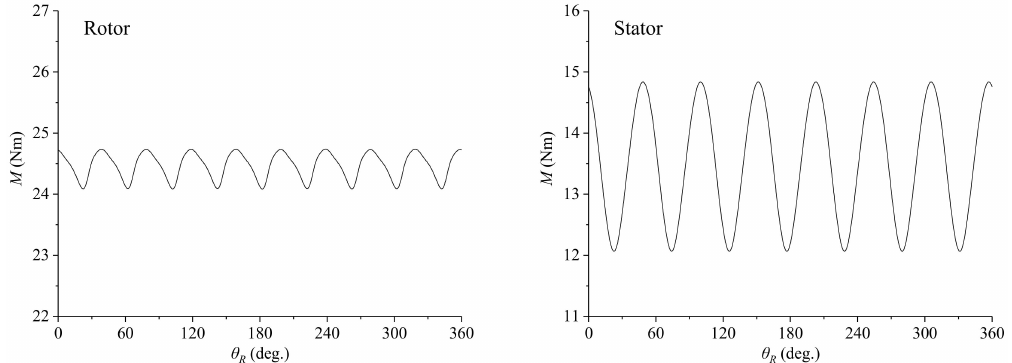
Figure 18. Oscillations of the torques on a rotor blade ( left ) and a stator blade ( right ). θ R denotes the angular position of the rotor blade. Q = 0.42 m 3